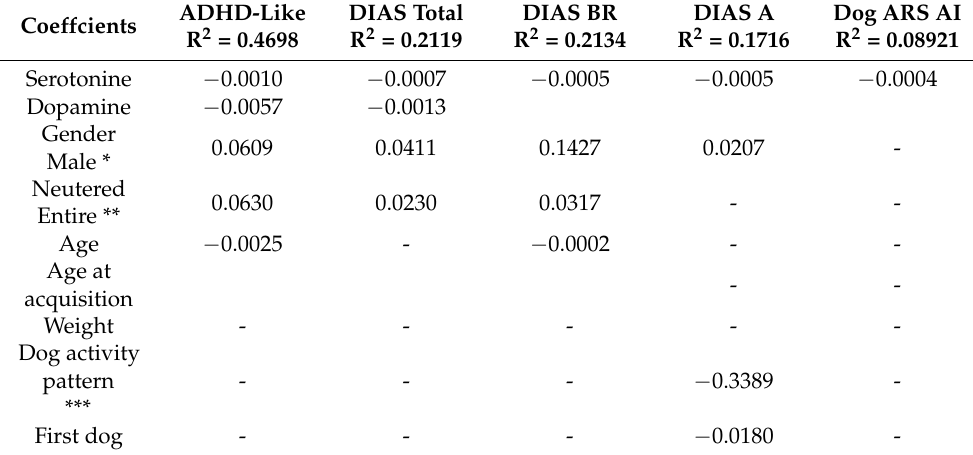
Table 4. Results of Lasso regression models for the effects of serotonin and dopamine serum concen- trations in dogs on ADHD-like diagnosis (yes/no) and scores (over and under the median) for the different DIAS and DOG ARS